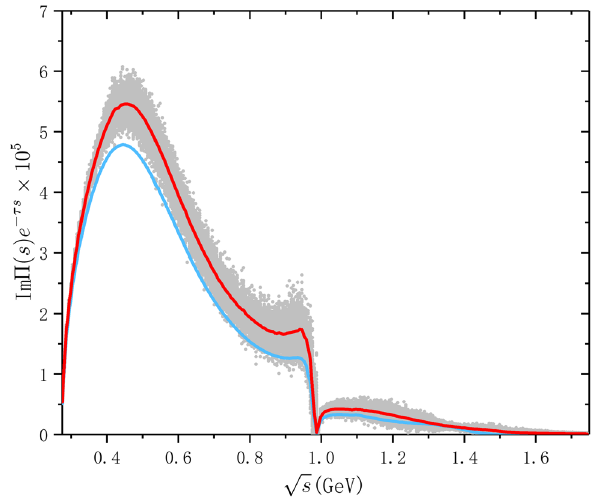
Fig. 2 The phenomenological spectrum functions Im (cid:3)( s ) multiplied by the Borel transformation factor e − τ s with τ = 1 . 0 GeV − 2 as a function of energy. The red line corresponds to the spectral function by using the best fit parameters and the corresponding amplitudes given in Ref. [24] and the surrounding gray areas are randomly generated according to the uncertainties estimated in the same reference. The blue line stands for the spectral function by taking the best fit parameters and relatedamplitudesfromRef.[25].Inbothcases,theeffectsintheenergy region beyond 1 GeV are found to be